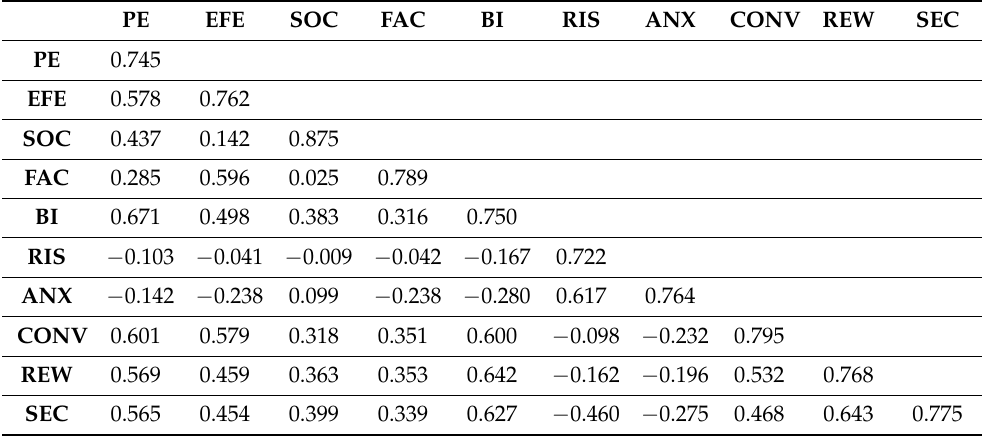
Table 2. Inter-correlations and square roots of AVE.